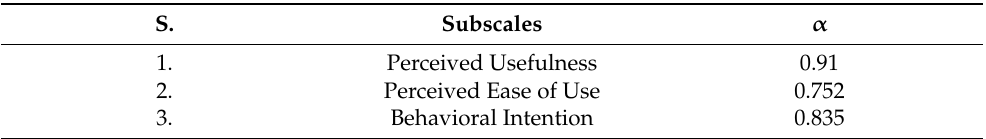
Table 2. Reliability of perceived usefulness, perceived ease of use, and behavioral intention for the teleclinic